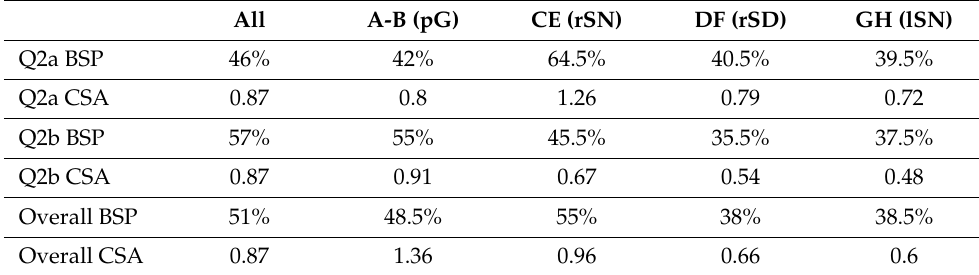
Table 6. Performance according to communication media and